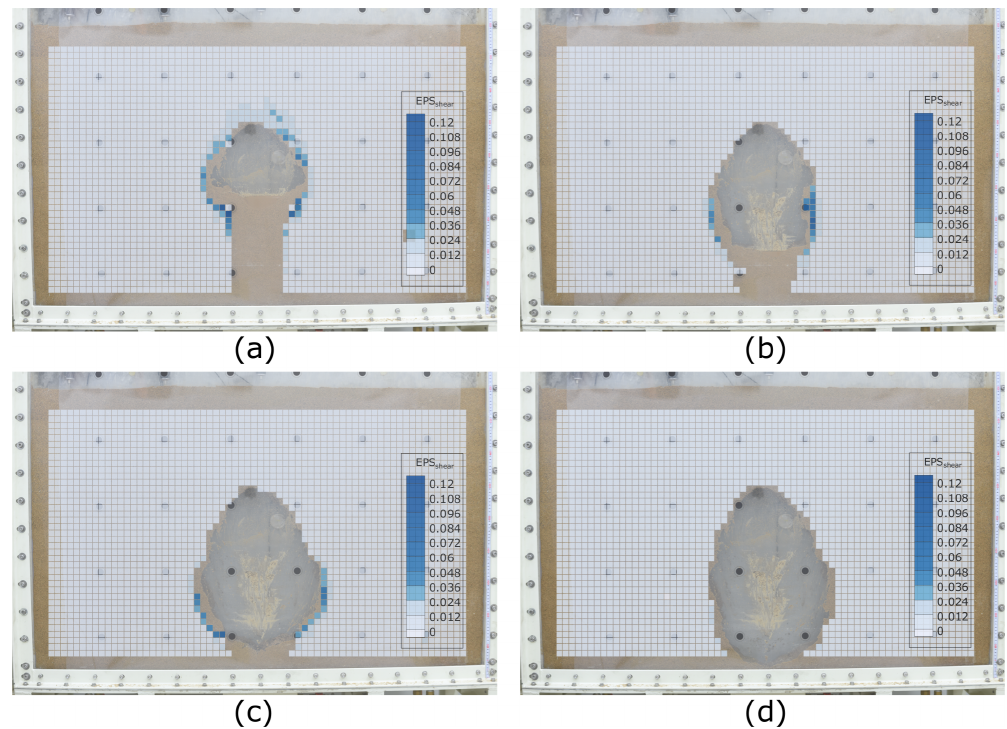
Figure 9. Shear strain inside the model ground for Test 2 during the water drainage stage: (a) 0–30s, (b) 30–60s, (c) 60–90s, and (d) 90– 120s.